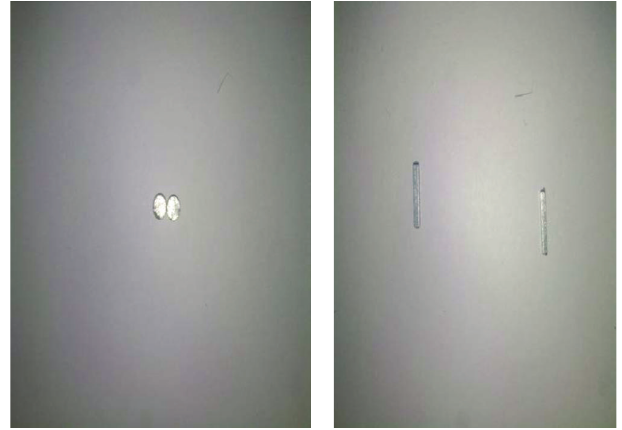
Figure 1: Different types of bluetooth devices extracted from the external auditory canal.